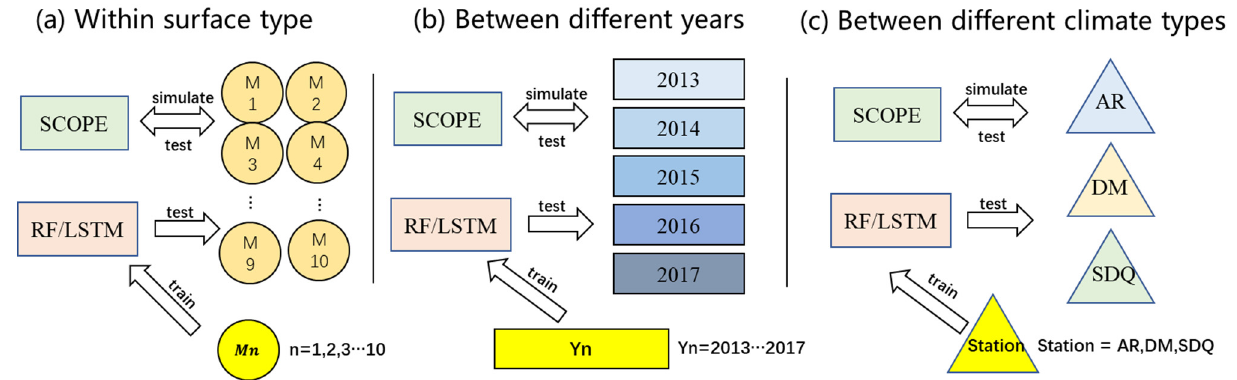
Figure 3. The concept map of the process of simulation and test for both empirical and physical methods. ( a – c ) corresponded to three different circumstances.